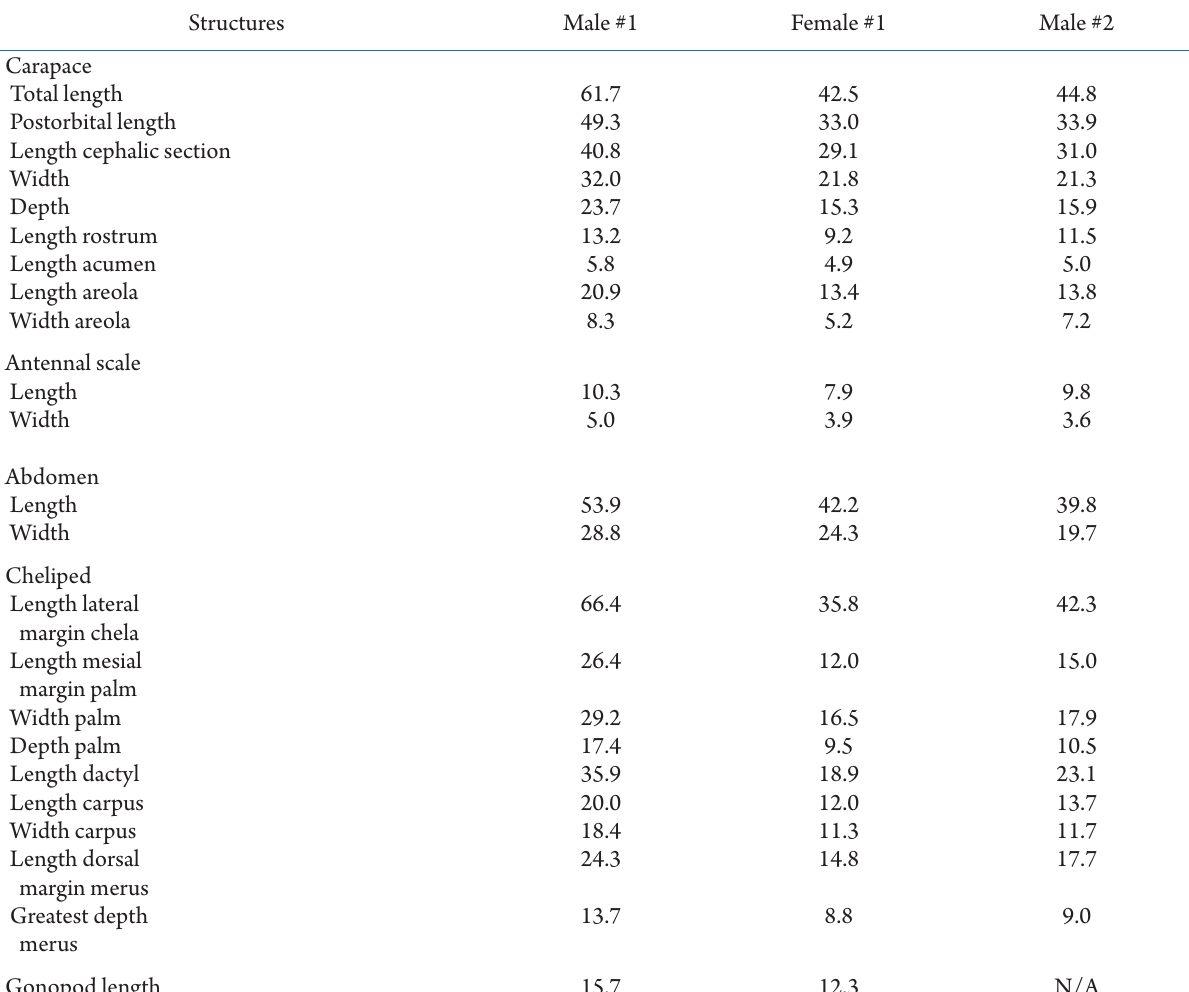
Table 2. Measurements (mm) of the syntypes (USNM 2080) of Pacifastacus leniusculus trowbridgii (Stimpson, 1857).